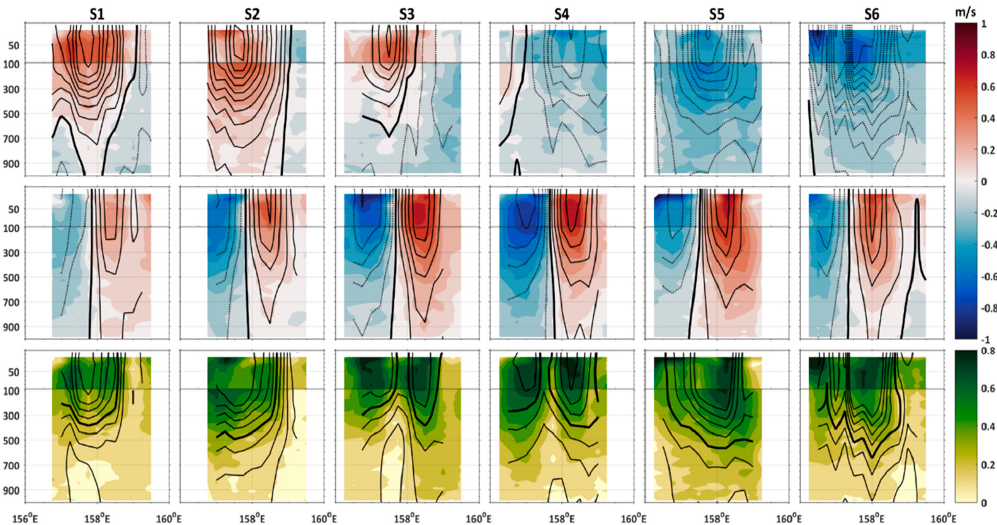
Figure 5. Observed velocity and geostrophic velocity. Shaded areas indicate the observed velocity, which were measured by the 300 kHz and 38 kHz ADCP at depths shallower and deeper than 90 m, respectively. The contours show the geostrophic currents, the solid and dotted lines indicate positive and negative velocities and the black (magenta) thick line is the observed (geostrophic) zero-velocity contour in the upper and middle panels and the 0.4 m s -1 contour in the bottom panel. Zonal velocity in the S1, S2, S3, S4, S5, S6 sections are shown in upper panels from left to right. Meridional velocity